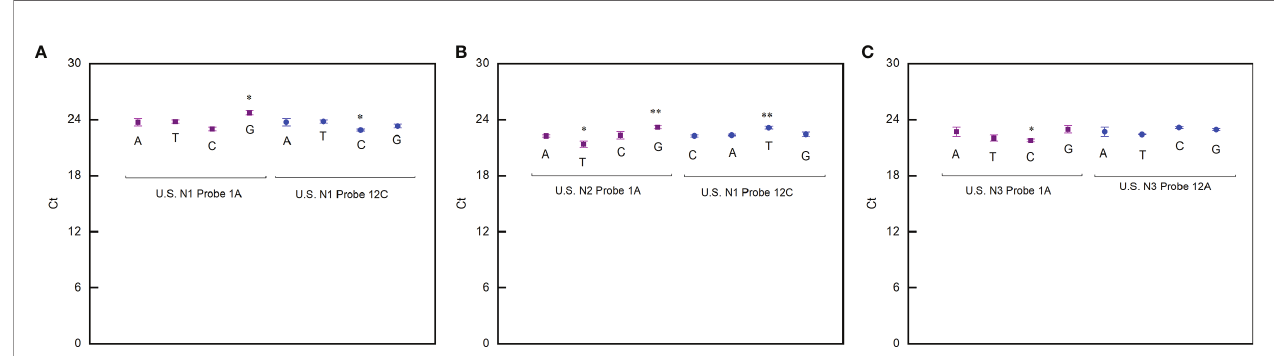
FIGURE 2 | Effect of mismatches between probes and template on PCR reaction. (A) Ct values detected when the US N1 probe contained mismatch with the template. (B) Ct values detected when the US N2 probe contained mismatch with the template. (C) Ct values detected when the US N3 probe contained mismatch with the template. Student ’ s t -test by SPSS 15 was used for data analysis. A p -value < 0.05 was considered statistically signi fi cant. * p < 0.05; ** p